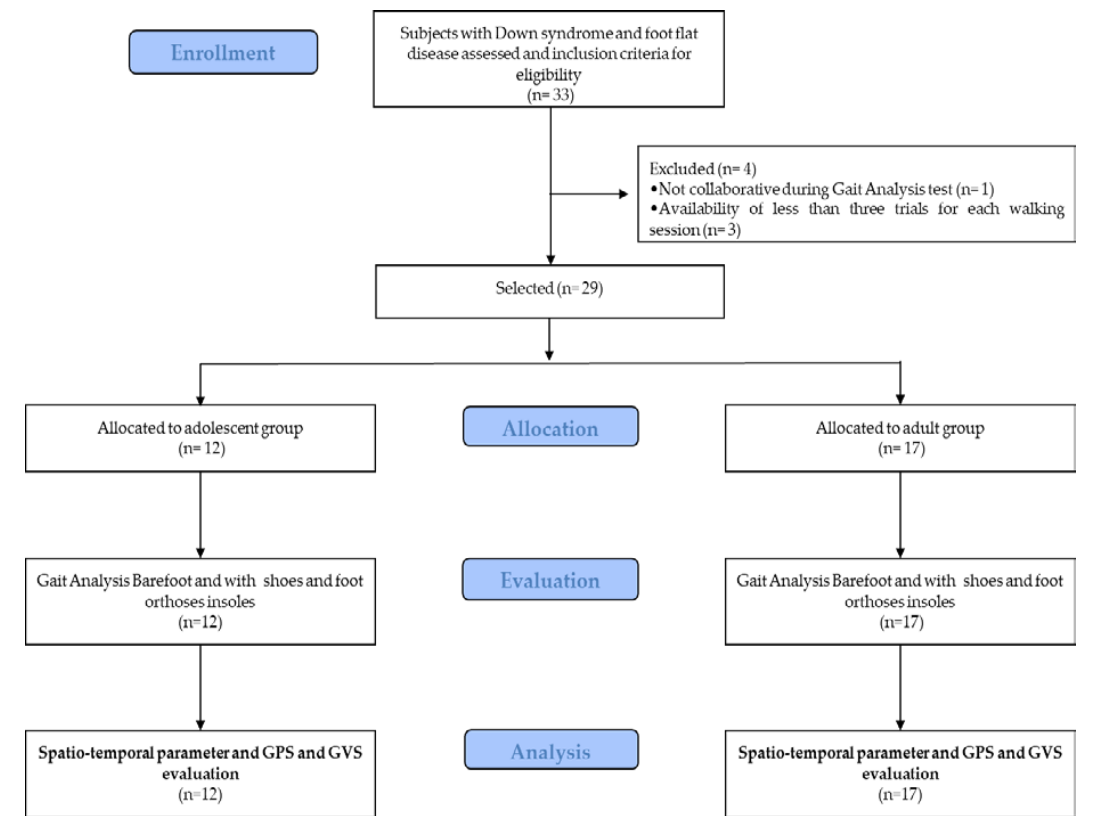
Figure 1. Flowchart of the experimental procedures. Table 1. Demographic and clinical characteristics of the adolescents and adults.